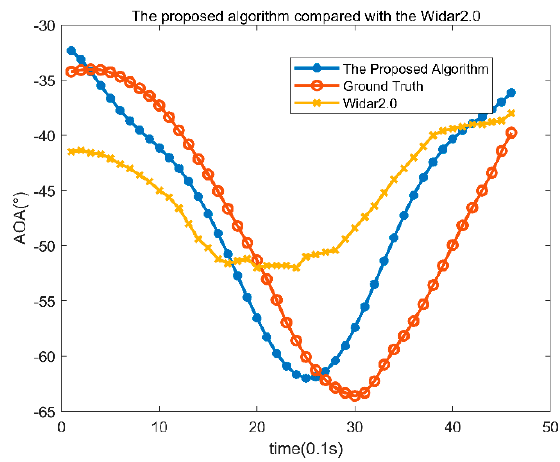
Figure 8. AOA results of classroom T02 data.